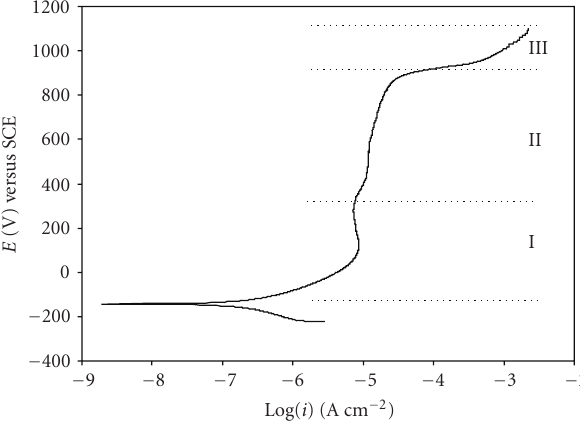
Figure 1: Potentiodynamic polarization curve for AISI 321 stainless steel in 0.5 M H 2 SO 4 . Potential regions: I-:low potential passive, II-:high potential passive, III-:transpassive